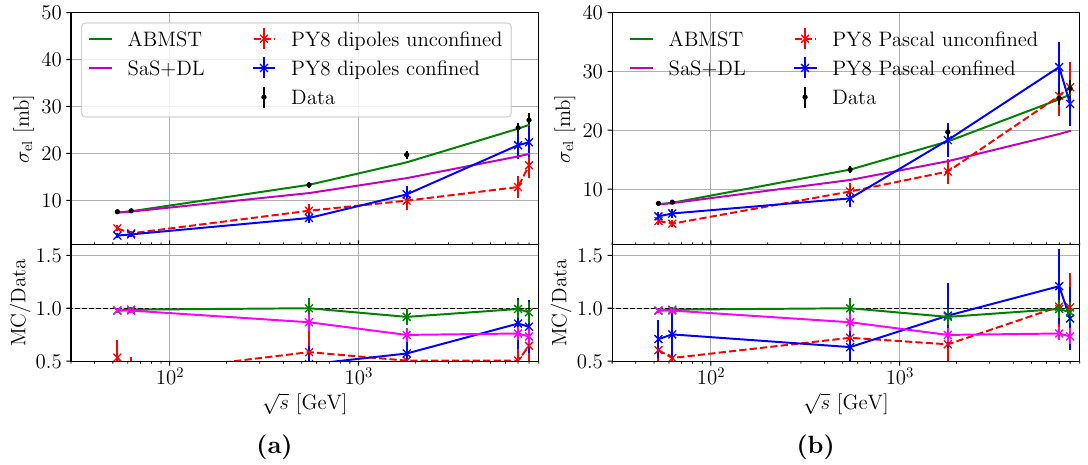
Figure 9. The elastic pp cross section as a function of p s for the dipole (a) and Pascal (b) models. Both show the con(cid:12)ned and uncon(cid:12)ned versions in solid blue and dashed red lines, respectively. Both (cid:12)gures show the ABMST (solid green lines) and SaS+DL (solid magenta lines) for comparison. model (b). Here, both models are undershooting the data by roughly 50% in the